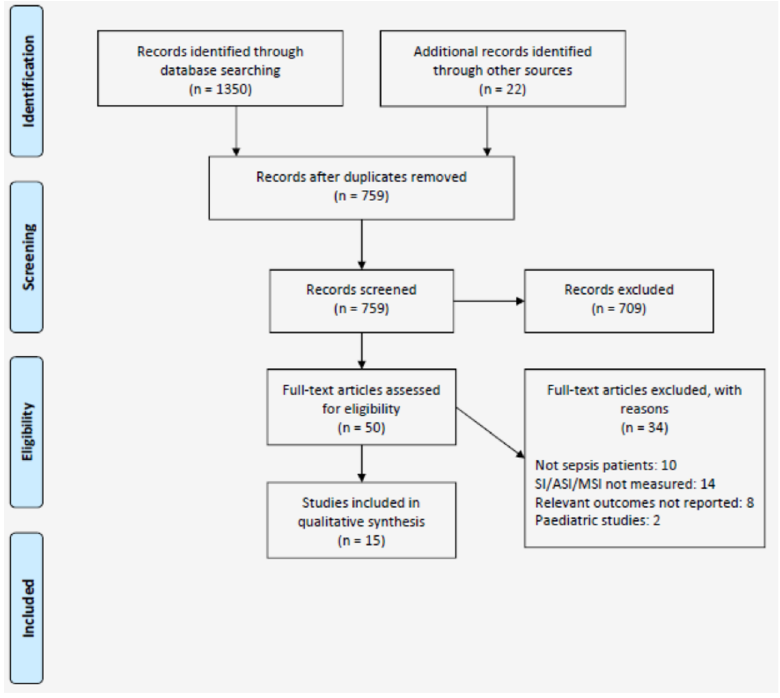
Figure 1. Preferred Reporting Items for Systematic Reviews and Meta-Analyses (PRISMA) flow Figure1. diagram.